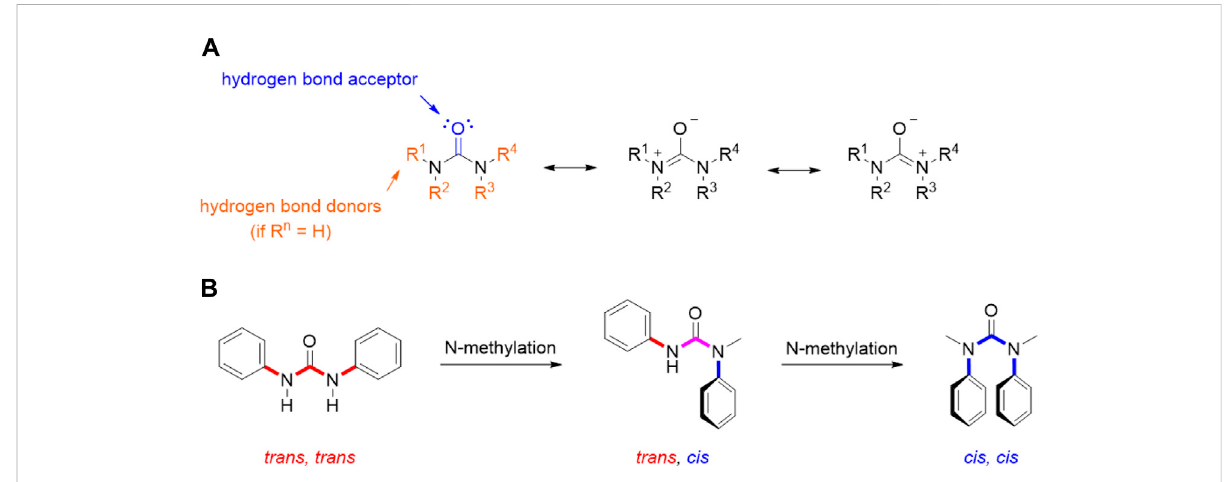
FIGURE 12 Resonance structure for urea moiety (A) ; conformations of N,N ′ -diphenyl urea, N-methyl-N,N ′ - diphenyl urea, and N,N ′ -dimethyl-N,N ′ - diphenyl urea (B)